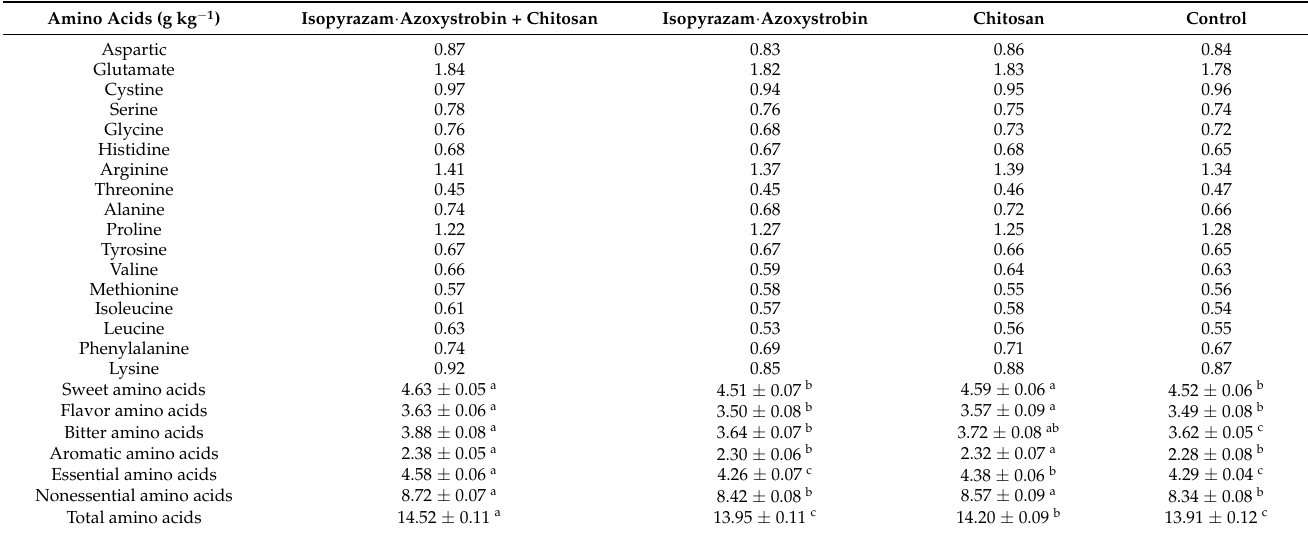
Table 5. The effects of isopyrazam · azoxystrobin and chitosan on amino acids of kiwifruit fruits. Amino Acids (g kg − 1 ) Isopyrazam · Azoxystrobin + Chitosan Chitosan Control